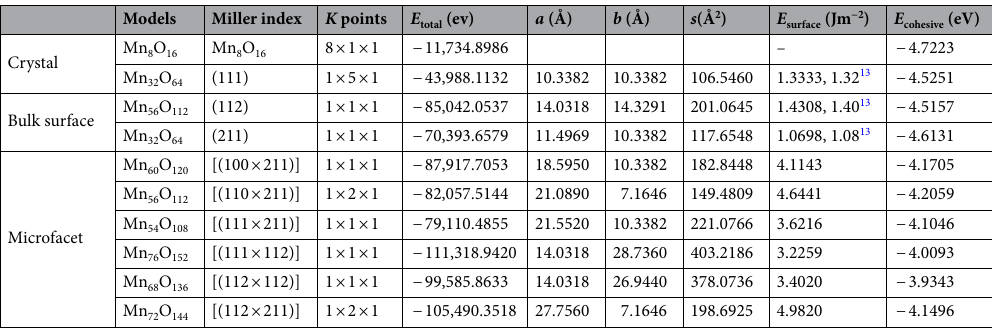
Table 1. Surface energy ( E surface ) and cohesive energy ( E cohesive ) of MnO 2 crystal, bulk surface and microfacet